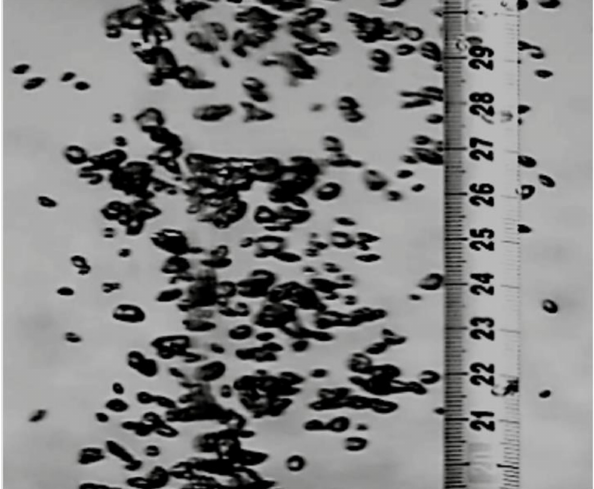
Figure 4. Experimental visualization of gas bubbles near the inlet (The minimum scale is